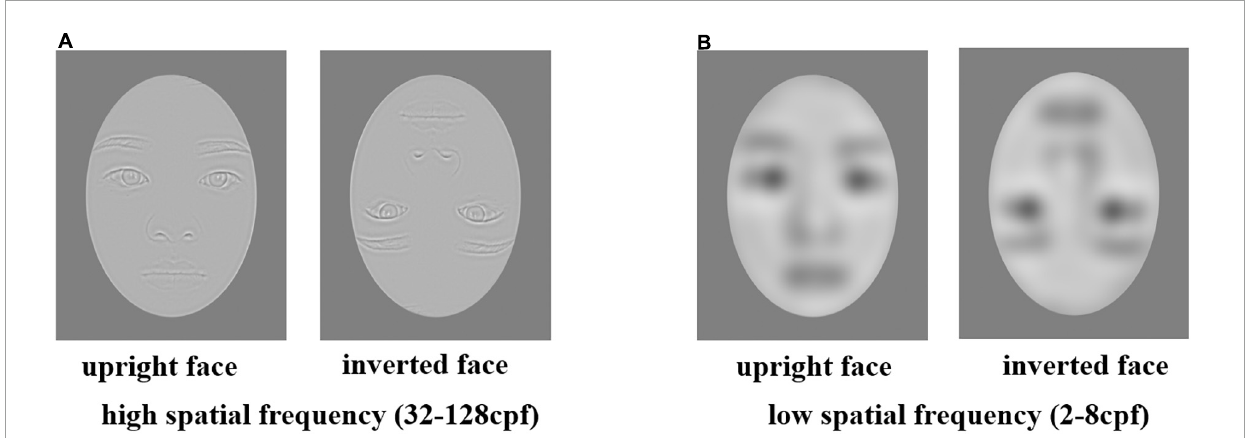
FIGURE4 Panel (A) is an example of a pair of upright and inverted faces in high spatial frequency conditions. Panel (B) shows the example of a pair of upright and inverted faces in low spatial frequency